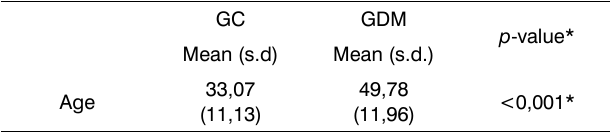
Table 2. Mean, Standard Deviation and p -value for age com- parisons in GC and GDM.